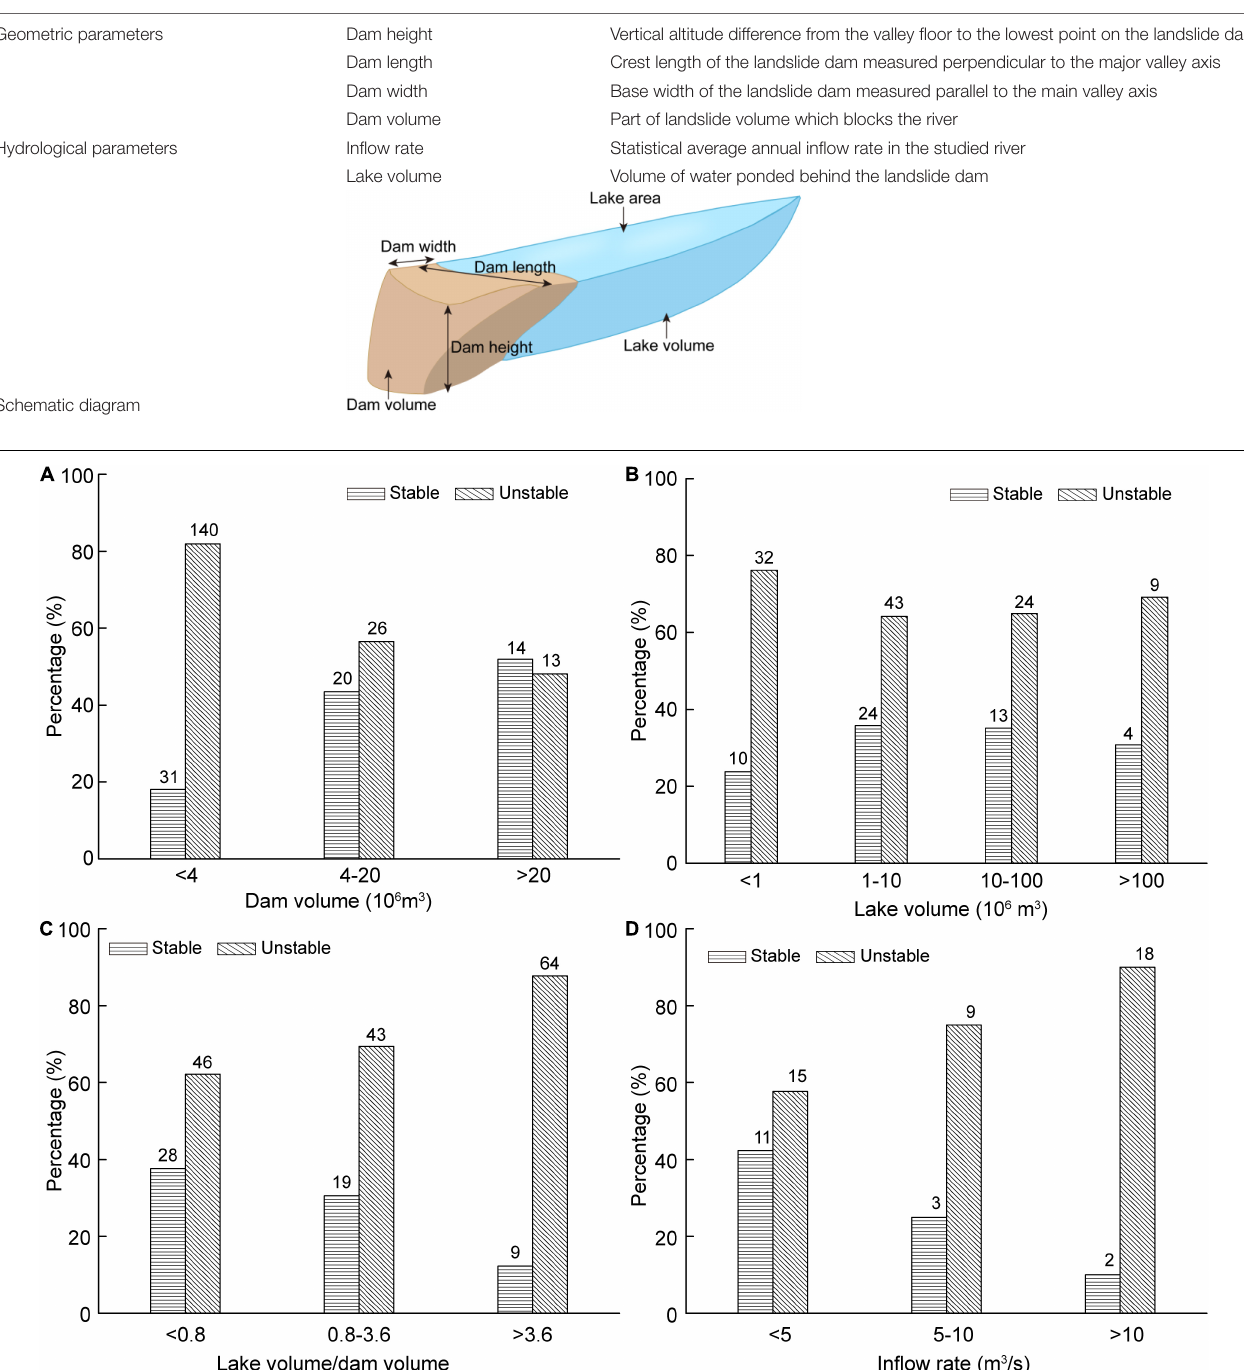
TABLE 1 | Geomorphic characteristics of landslide dams (Peng and Zhang, 2012).